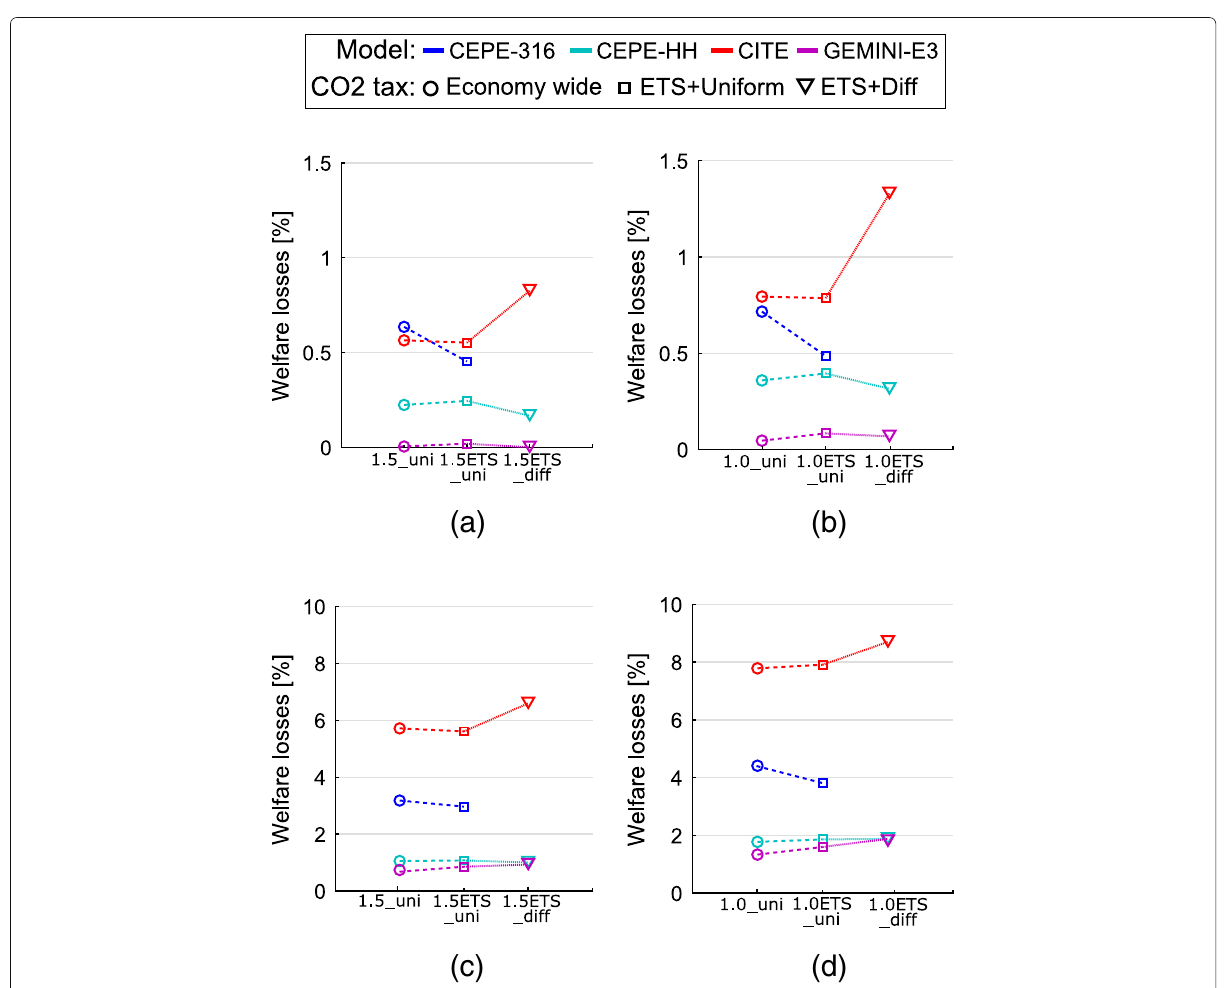
Fig. 9 Welfare losses in single model periods across different policies according to the various CGE models. a 1.5 tpc scenarios in 2025. b 1.0 tpc scenarios in 2025. c 1.5 tpc scenarios in 2050. d 1.0 tpc scenarios in